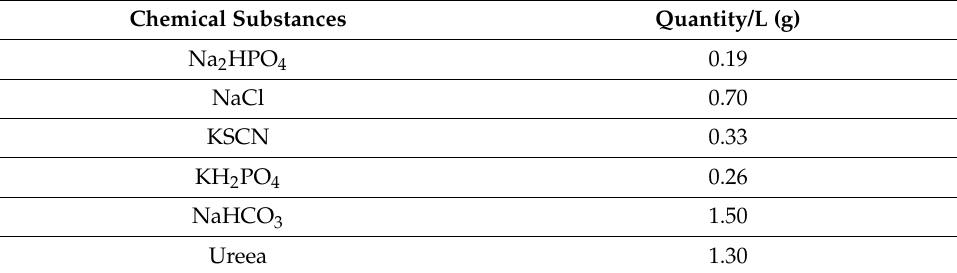
Table 2. Chemical composition of Carter Brugirard artificial saliva.